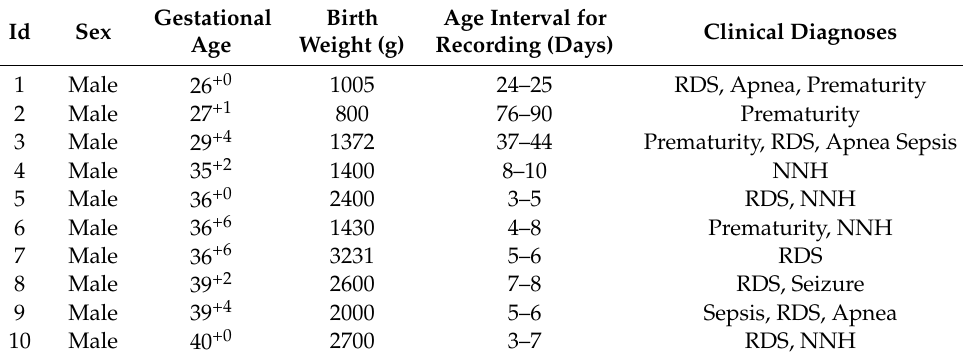
Table 2. Baseline characteristics of the sample (enrolled subjects, n =